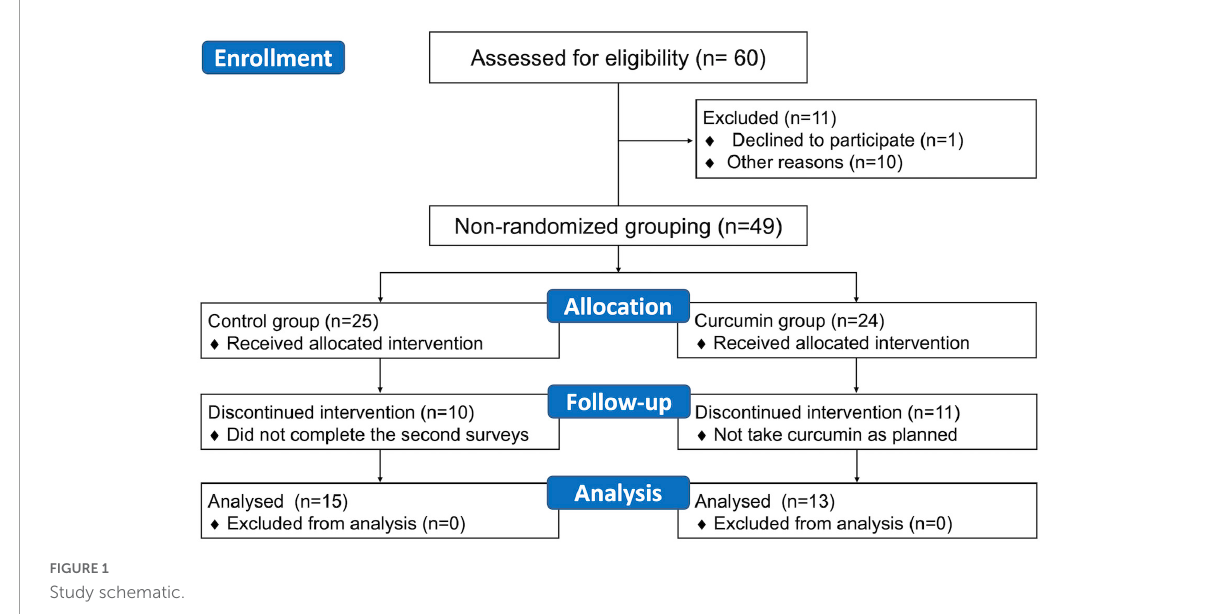
FIGURE1 Study schematic.